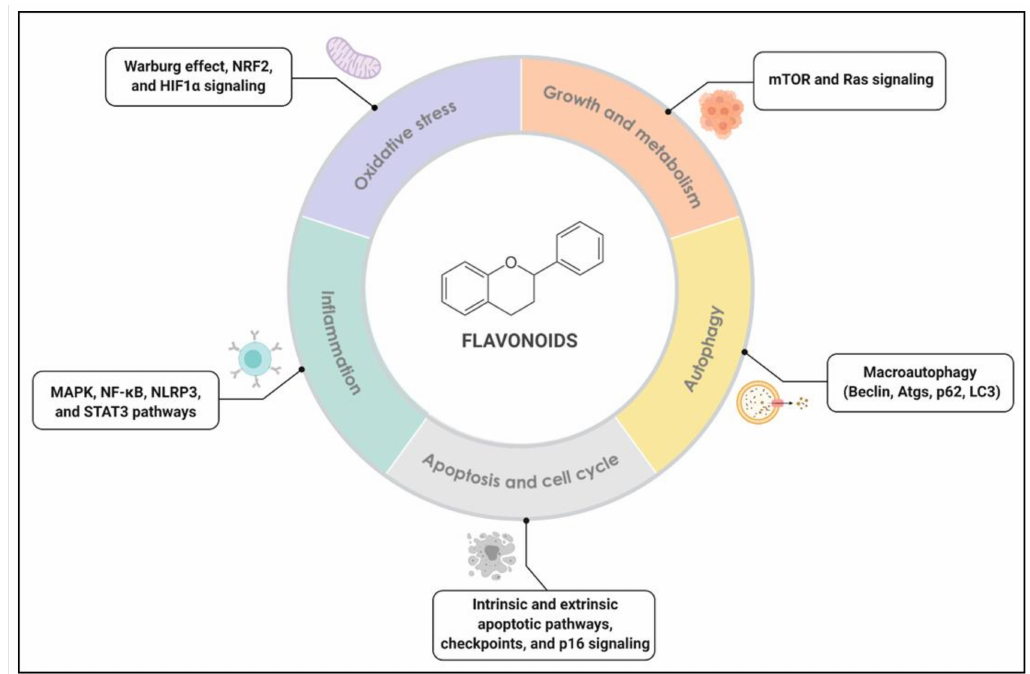
Figure 1. The molecular actions of flavonoids in cell signaling in cancer. Flavonoids significantly alter the biological processes involved in cancer, including inflammation and immunity, redox metabolism, cell growth, autophagy, apoptosis, and cell cycle. Signaling pathways related to these biological processes, which include Mitogen-Activated Protein Kinases (MAPK), Nuclear Factor- κ B (NF-kB), Nod-Like Receptor Pyrin domain containing 3 (NLRP3) inflammasome, Signal Transducer and Activator of Transcription 3 (STAT3) pathway, Warburg effect, Nuclear Factor Erythroid 2-related Factor 2 (NRF2), Hypoxia-Inducible Factor 1 alpha (HIF1 α ), mechanistic Target Of Rapamycin (mTOR), Ras, macroautophagy, cell cycle checkpoints, intrinsic and extrinsic apoptotic pathways, and senescence, are modulated by flavonoids in cancer and highlighted in this figure. Original figure made for this review using the Biorender